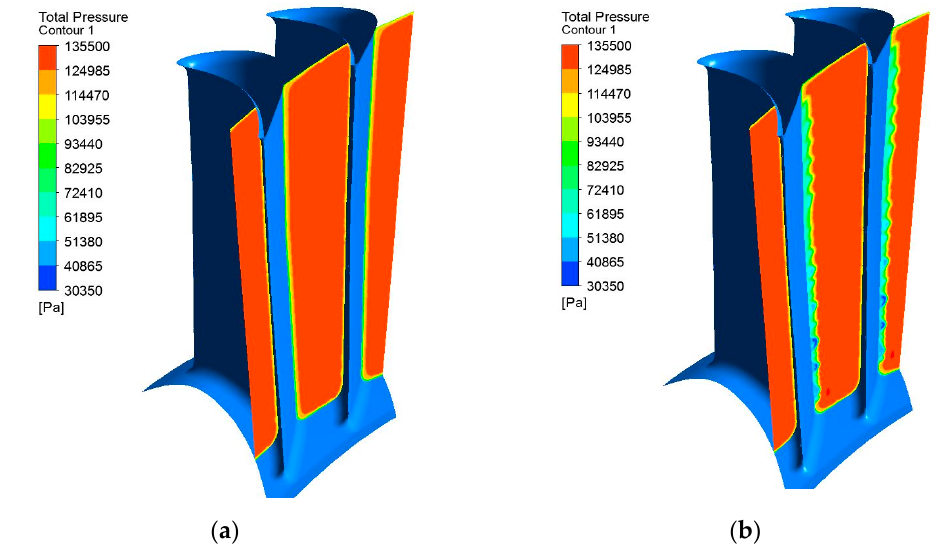
Figure 7. ( a ) Total pressure distribution without injection; ( b ) Total pressure distribution after the injection process.